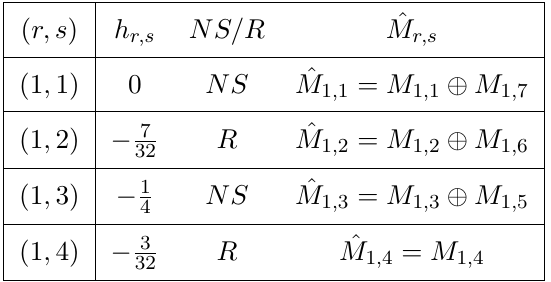
Table 17 . The representations of the super-Virasoro algebra at c = (cid:0) 21 = 4.